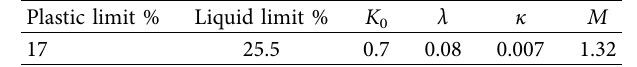
Figure 4: Soil particle gradation curve. Table 2: Physical parameters for